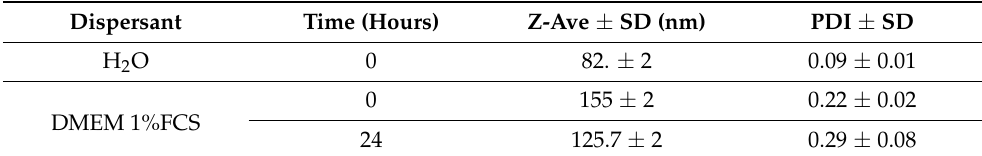
Table 1. DLS characterization. Z average and PDI values ( ± SD) of fluorescent SiO 2 nanobeads dispersion (100 µg/mL).